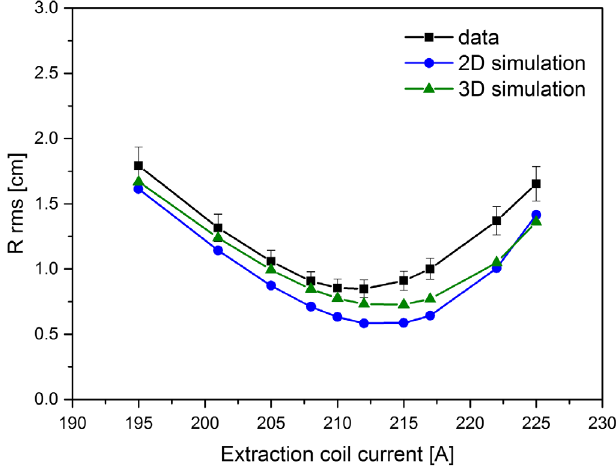
FIG. 10. Comparison of rms beam radii at BPM 3 for various extraction coil currents: measured (black squares) and simulated using an axisymmetric 2D geometry (blue circles) and a Cartesian 3D geometry (green